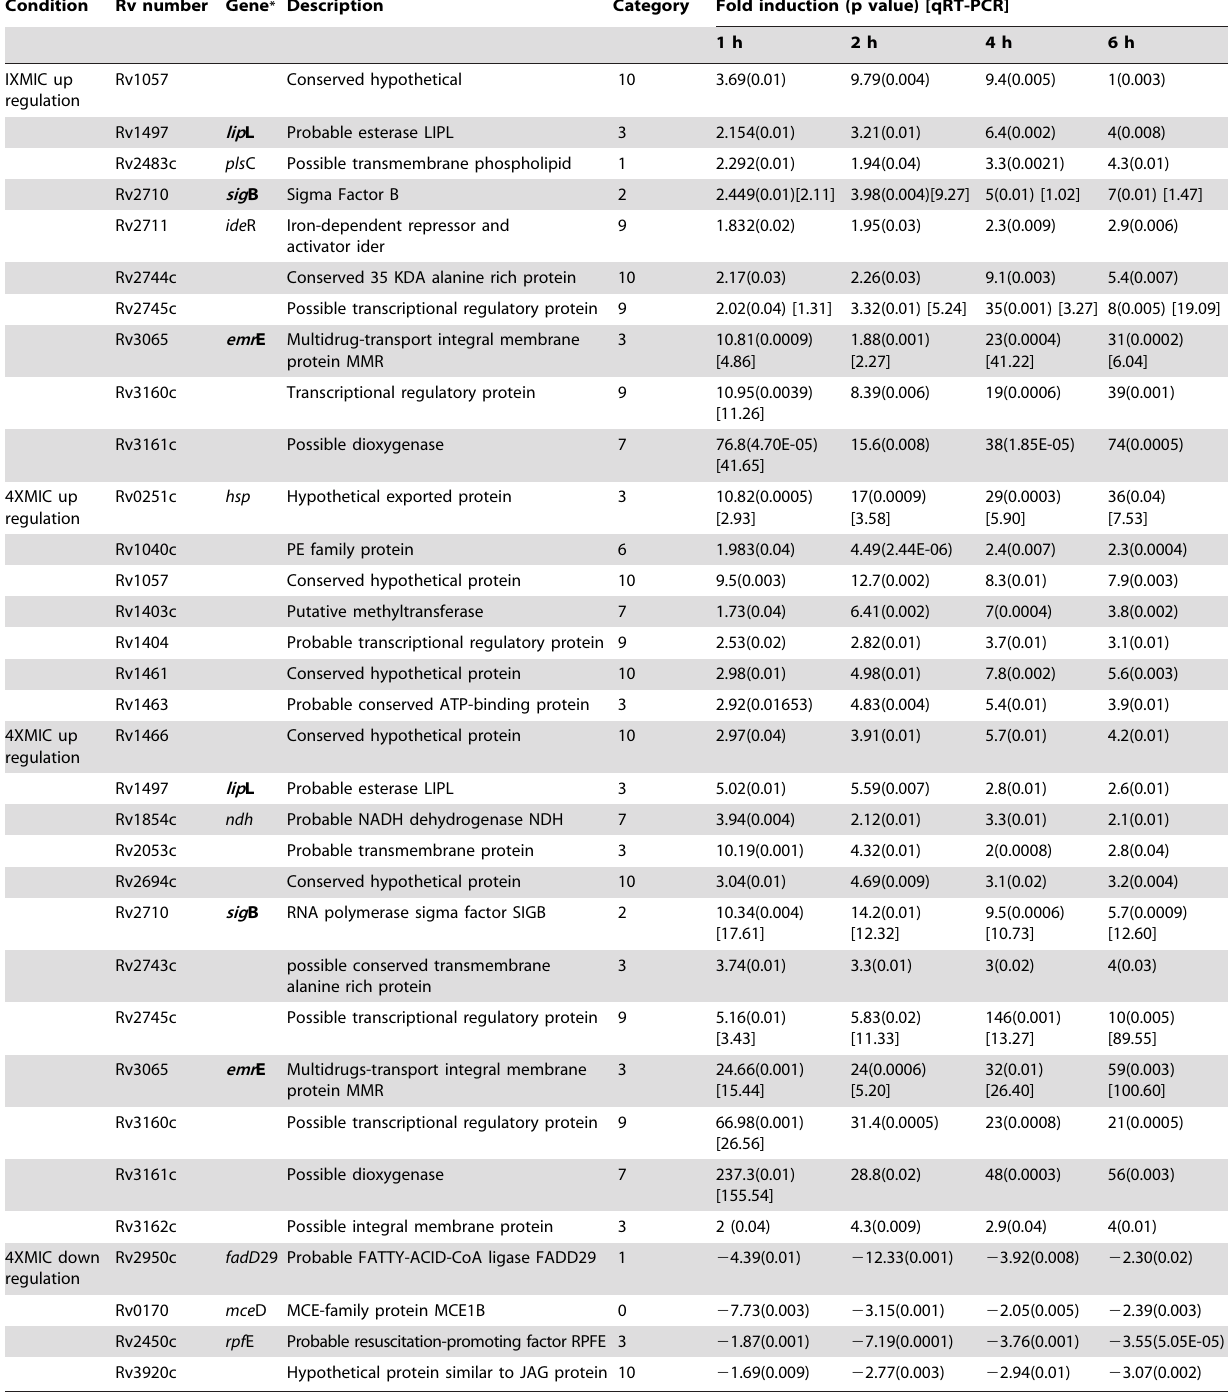
Table 1. Genes induced in all condition